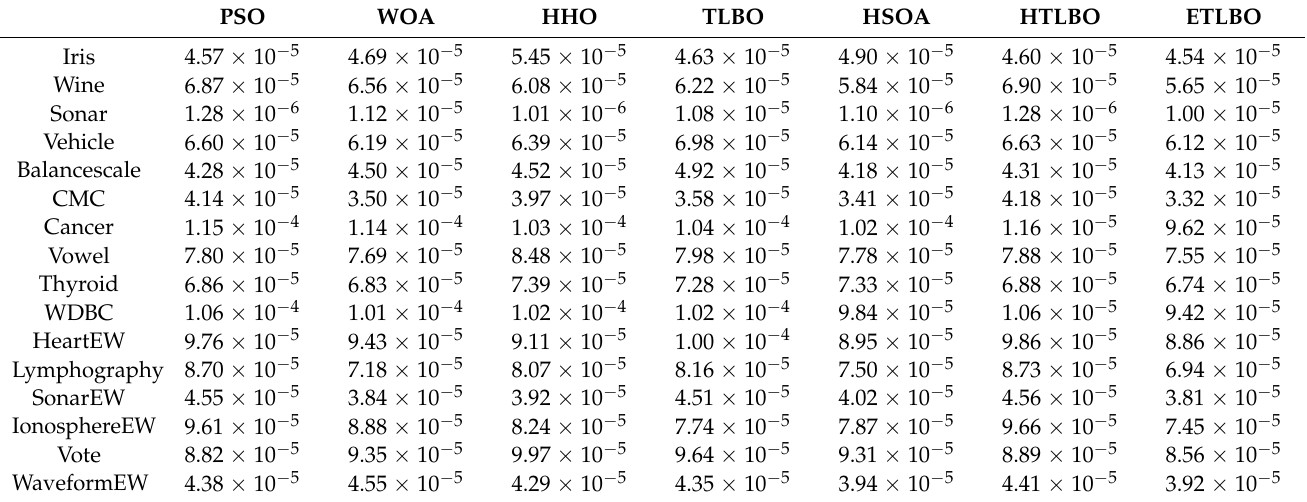
Table 8. The std of classification accuracy.